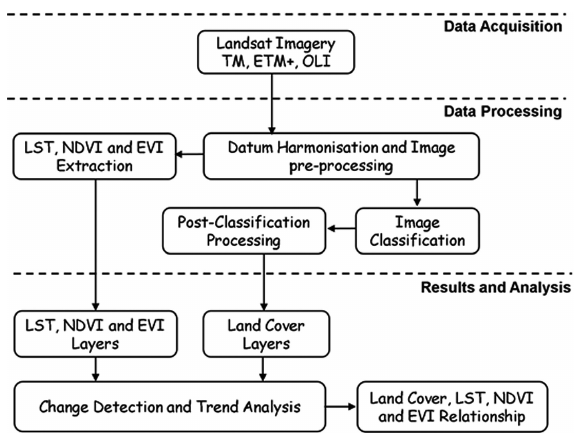
Fig. 2. The workflow of the